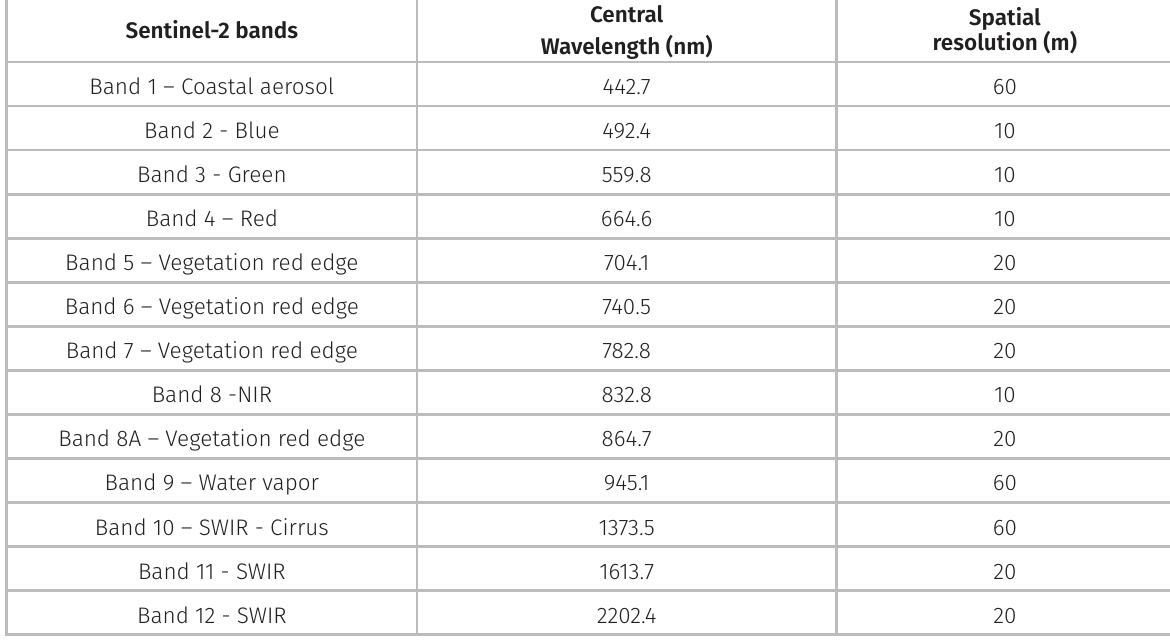
Table I. List of bands, central wavelengths, and spatial resolution of Sentinel-2